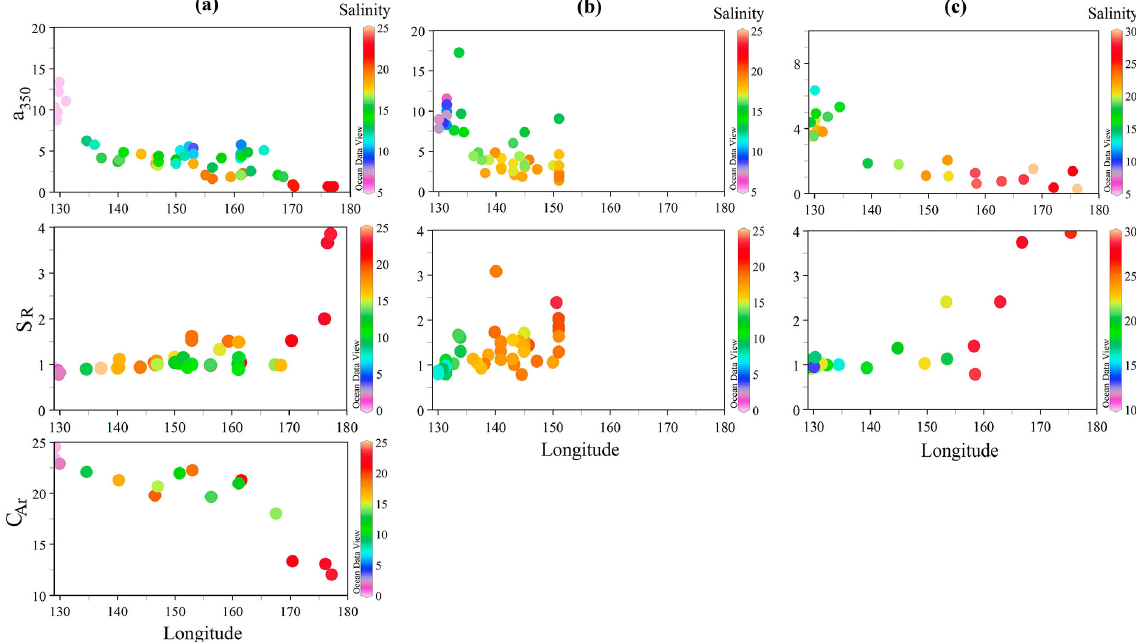
Figure 6. The relationship between CDOM absorption coefficient at the 350nm wavelength ( a 350 , m − 1 ), S R , the aromatic carbon content ( C Ar , %), and salinity in the ESAS surface waters for September 2004 (a) , 2005 (b) , and 2011 (c)